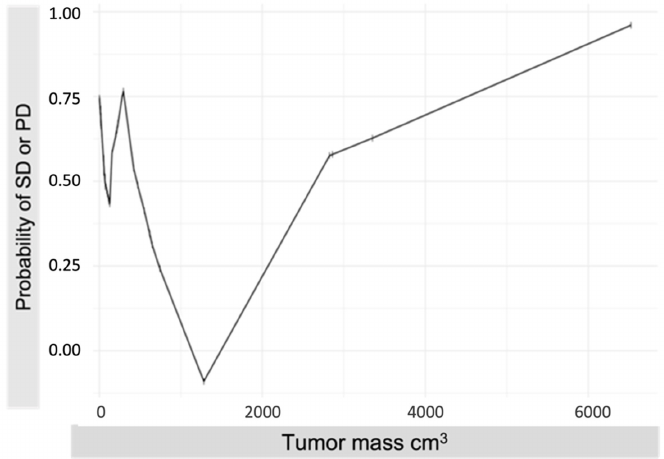
Figure 2. Univariable association between tumor mass and stable or progressive disease. The spike histogram shows the probability of a non-regressive response (stable disease (SD) and progressive disease (PD)) by binning the tumor mass into equal intervals and counting SD/PD in each bin. In comparison to patients with either low (<500 cm 3 ) or high (>2000 cm 3 ) tumor mass, patients with medium (500–2000 cm 3 ) tumor mass have a lower probability of SD/PD and thus a higher probability for PR/CR. The proportional odds model (Table 5) suggested that a higher number of therapy lines prior to PHP raises the odds of a poorer response (lines 2:1, 1.96 (1.13–3.39)). Table 5. Proportional odds model relating line of therapy to response after therapy (CR/PR versus SD versus PD). The parameter estimates β , the standard errors S.E., the statistic (Wald Z), the p -value (Pr (>|Z|)), the difference between the higher and lower value of the predictor being compared (Differ- ence), the odds ratio (Odds ratio), and the 95% confidence interval (Lower 95% CI, Upper 95% CI). PHP: percutaneous hepatic perfusion.